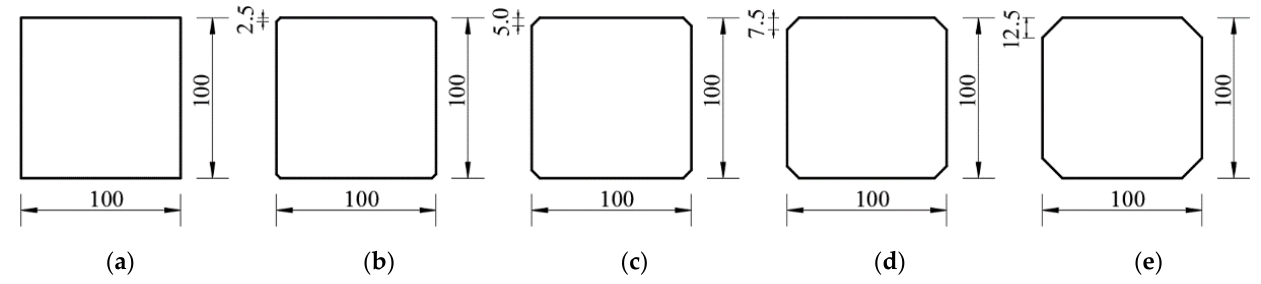
Figure 3. Cross-sections of MDOF model with chamfered corner (unit: mm): ( a ) chamfer ratio 0%; ( b ) chamfer ratio 2.5%; ( c ) chamfer ratio 5%; ( d ) chamfer ratio 7.5%; ( e ) chamfer ratio 12.5%.